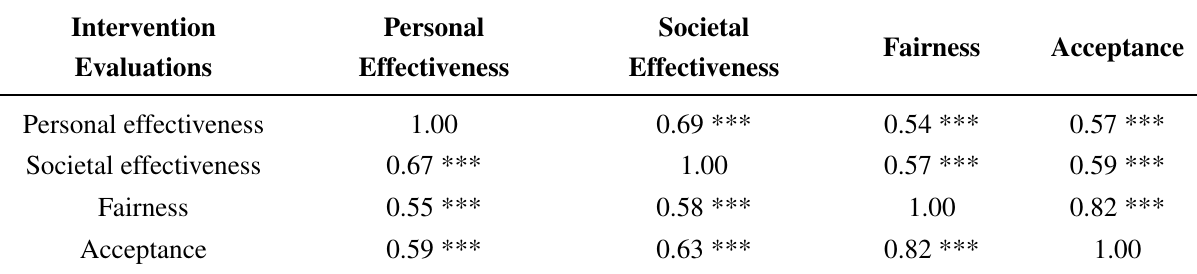
Table 3. Correlations between intervention-specific beliefs and acceptance of beverage interventions (upper part) and snack food interventions (lower